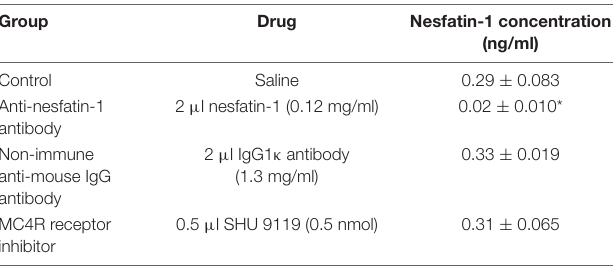
The drugs were administered to mice by ICV injection once daily for 14 days. The data represent the mean ± SD. n = 6 per group. *p < 0.05, compared to the controls. MC4R, Melanocortin 4